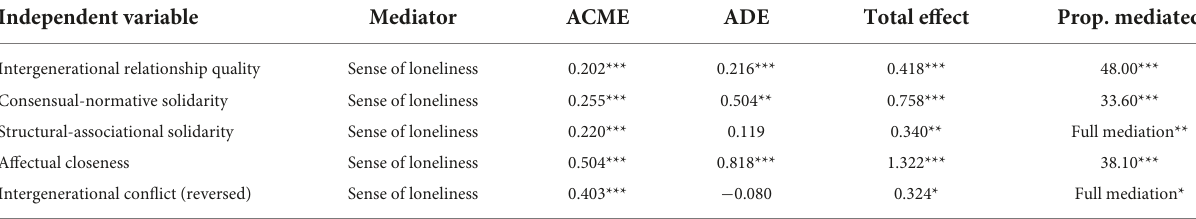
TABLE 4 Mediating effects of the sense of loneliness.